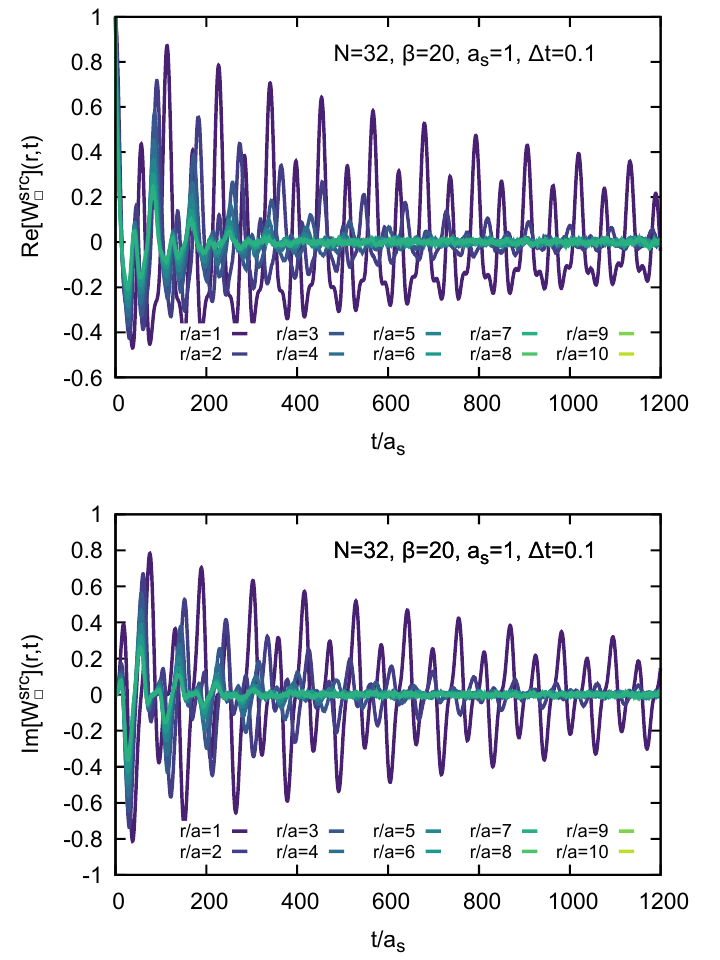
Figure 5 . Real- (top) and imaginary (bottom) part of the trace of the real-time Wilson loop trace h W i evaluated with sources placed at different spatial on-axis separation distances between r = 1 . . . 10 a s on N x = 32 lattices with β = 20 . In the presence of back-reaction, both quantities show finite values and exhibit a combination of oscillatory and damping